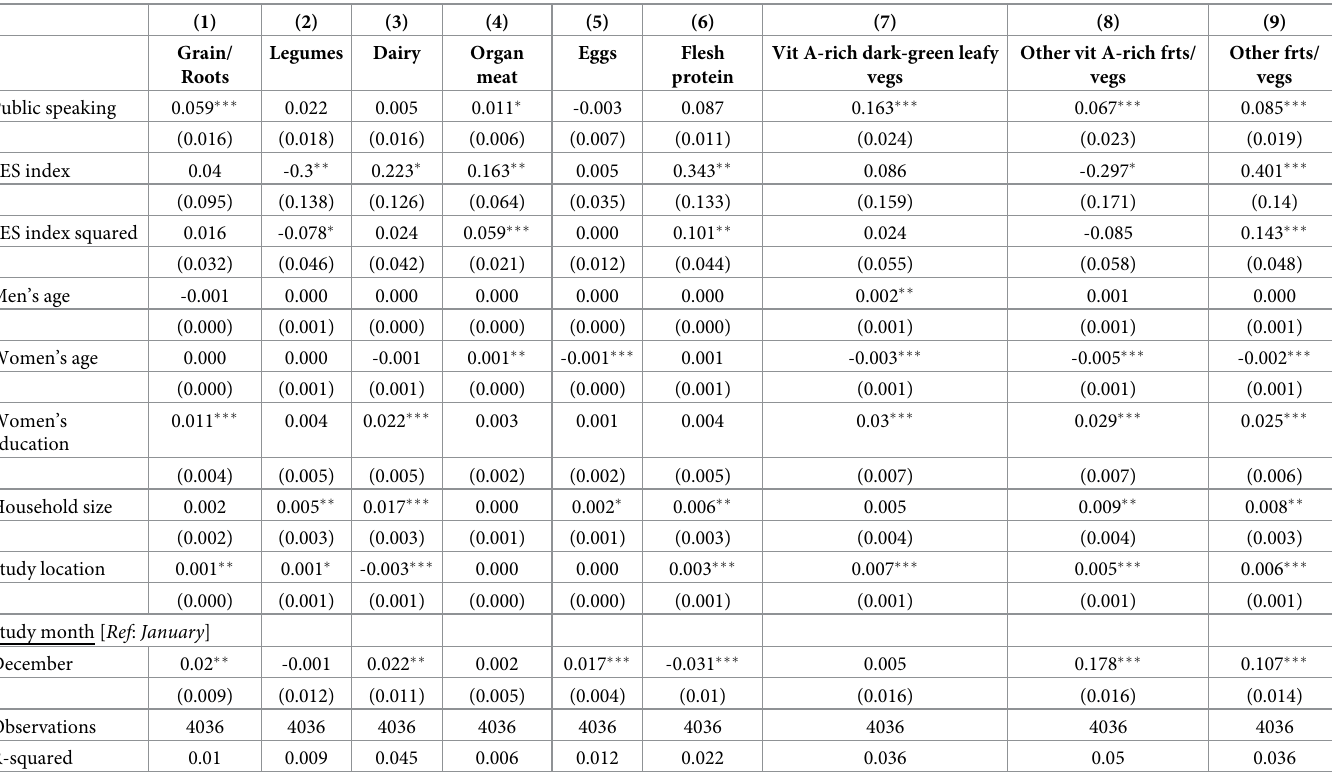
Table 21. LPM regression for food groups consumed–leadership domain (Comfortable speaking in public in � 1